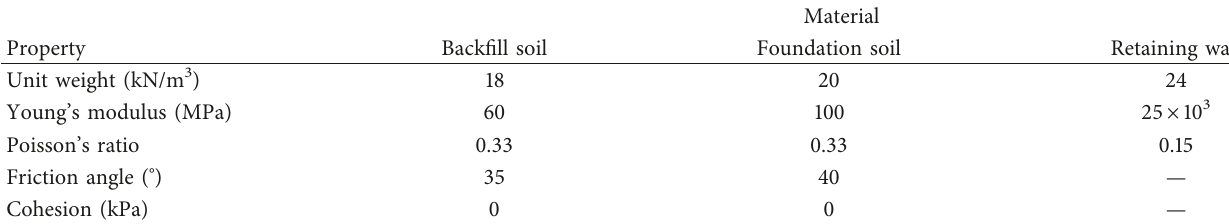
Table 2: Material properties.